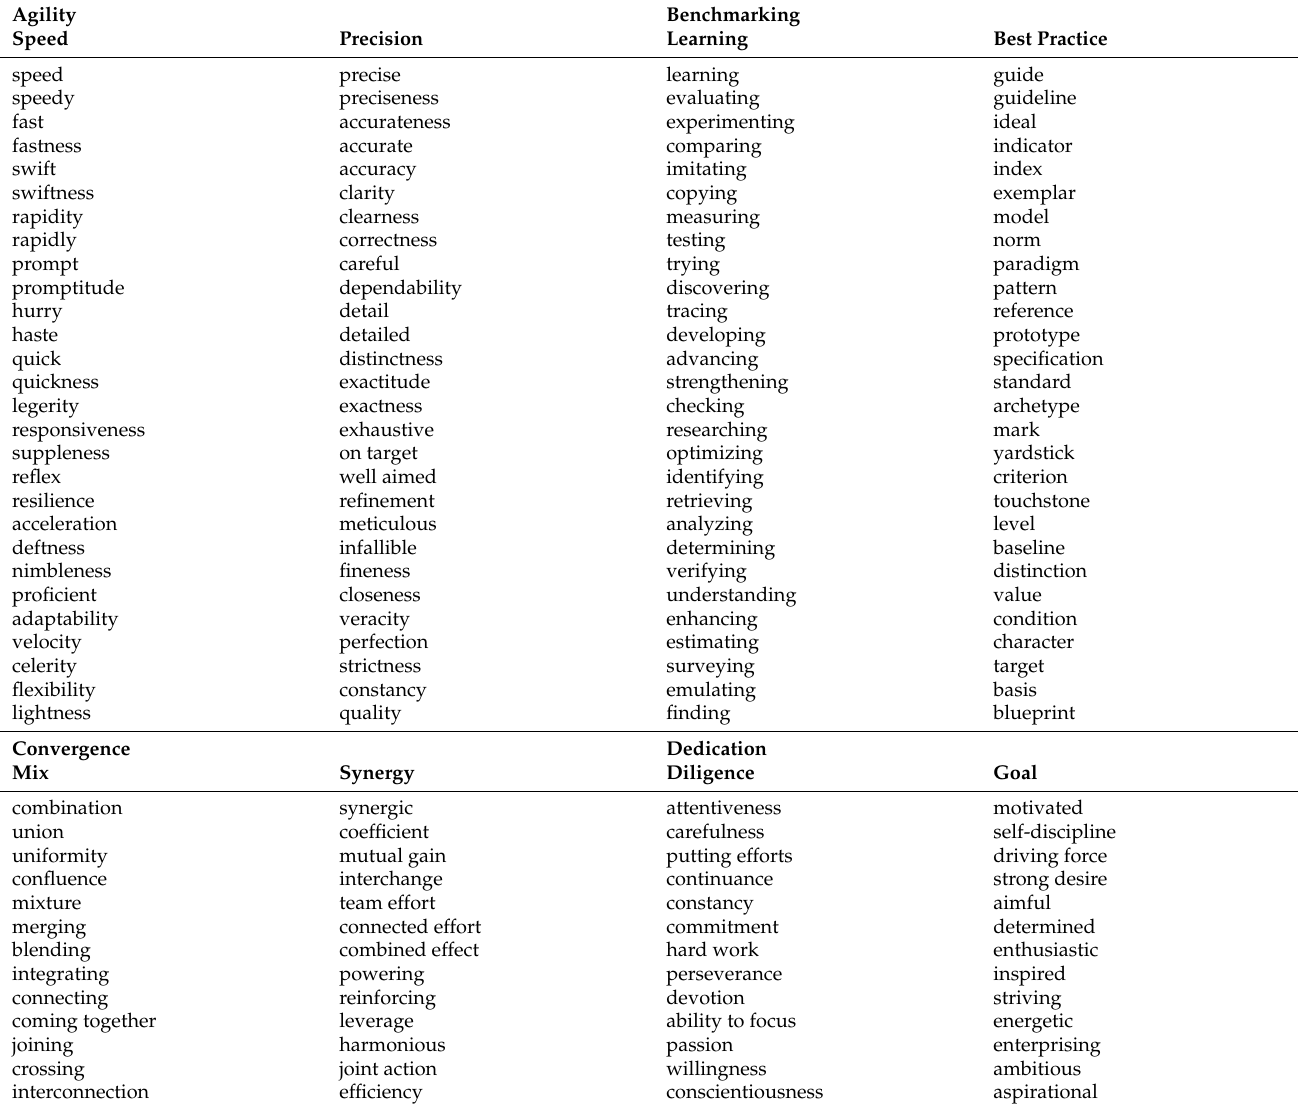
Table 1. Keywords for the ABCD